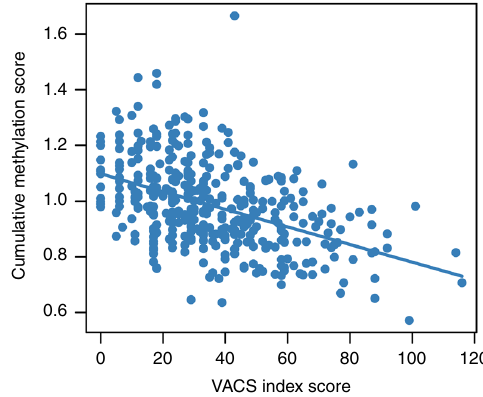
Fig. 4 Methylation risk score is highly correlated with HIV frailty. Correlation of methylation risk score constructed by 748 probes with the VACS index (Veteran Aging Cohort Study) in combining samples of injection drug use with HCV infection (IDU+/HCV+) and non-injection drug use without HCV infection (IDU − /HCV − ) in the HIV-infected samples from the VACS was retained as a test set.